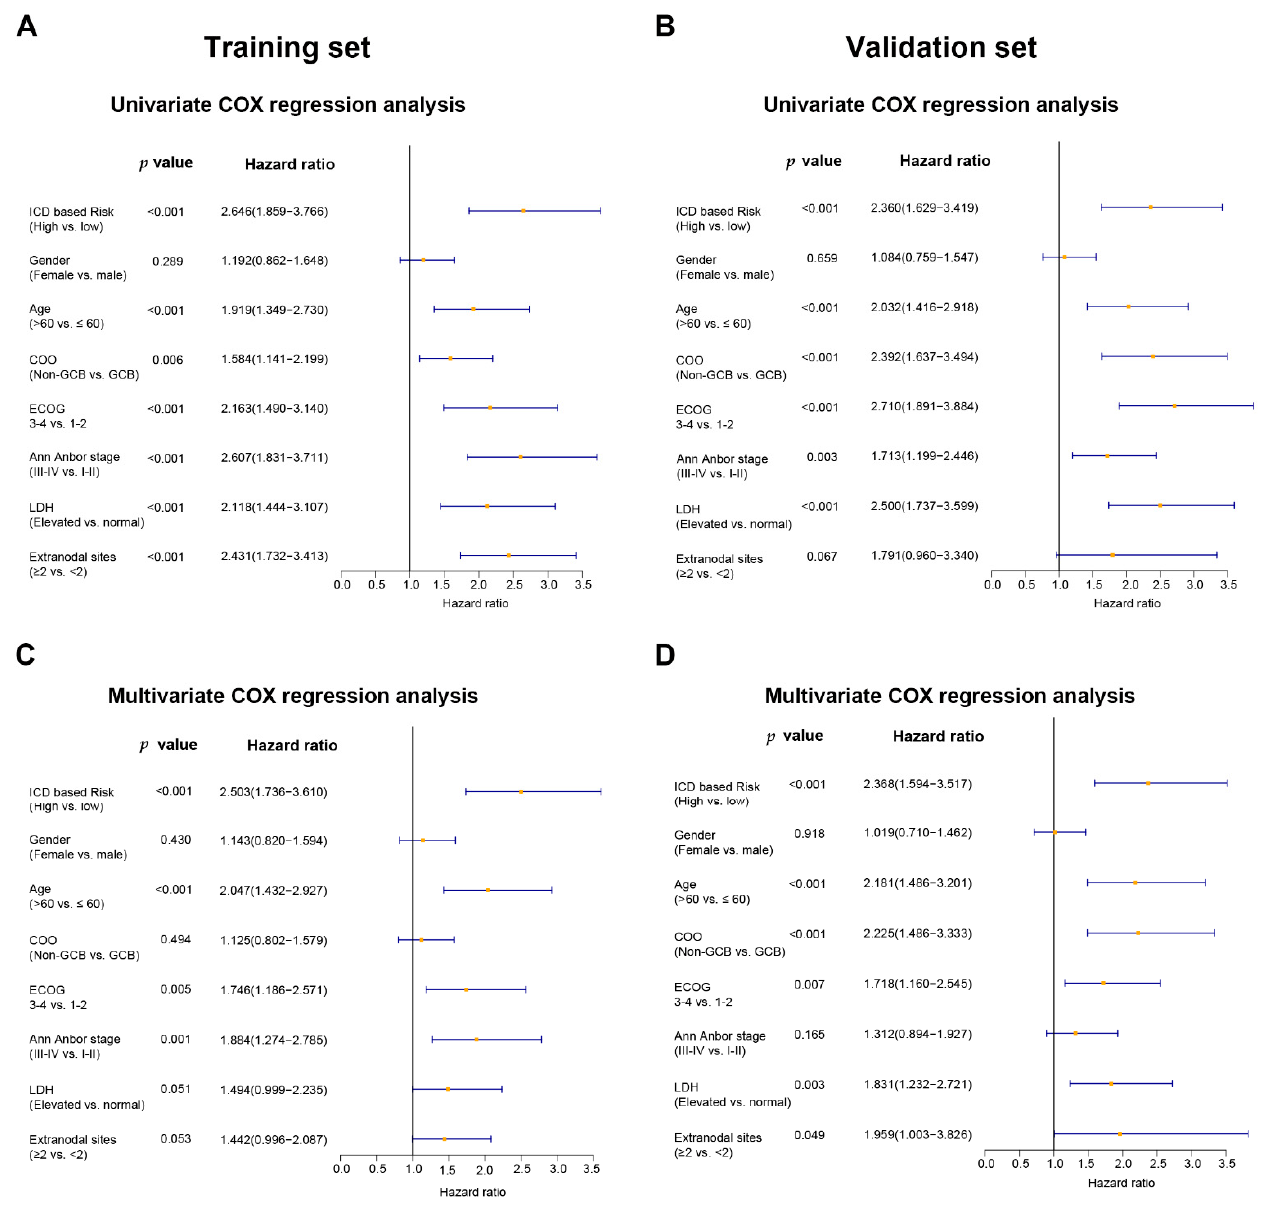
Figure 4. For DLBCL patients, the ICD-related gene signature is an independent predictive factor. The multivariate and univariate Cox regression analyses of OS calculated in the training set ( A , C ) and the validation set ( B , D ). Abbreviations: COO, cell of origin; GCB, germinal center B cells; ECOG, Eastern Cooperative Oncology Group; LDH, lactate dehydrogenase.